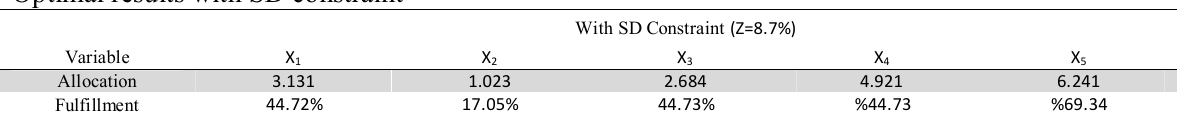
Optimal results with SD constraint